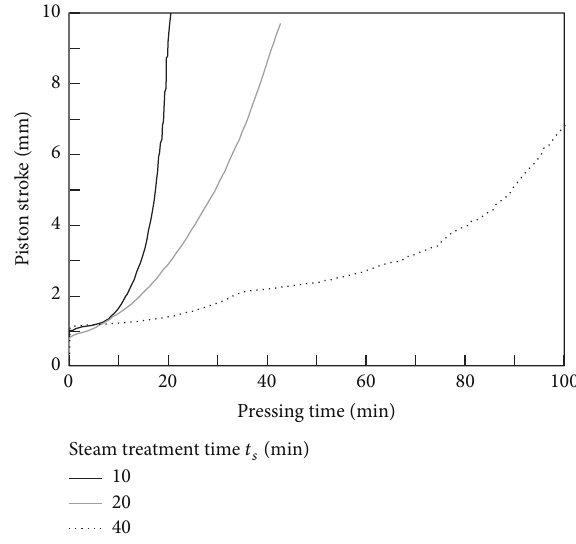
Figure 6: Effect of steam treatment time 𝑡 ℎ on the thermal flow curve. ( 𝑇 𝑠 = 200 ∘ C and 𝑡 ℎ = 5